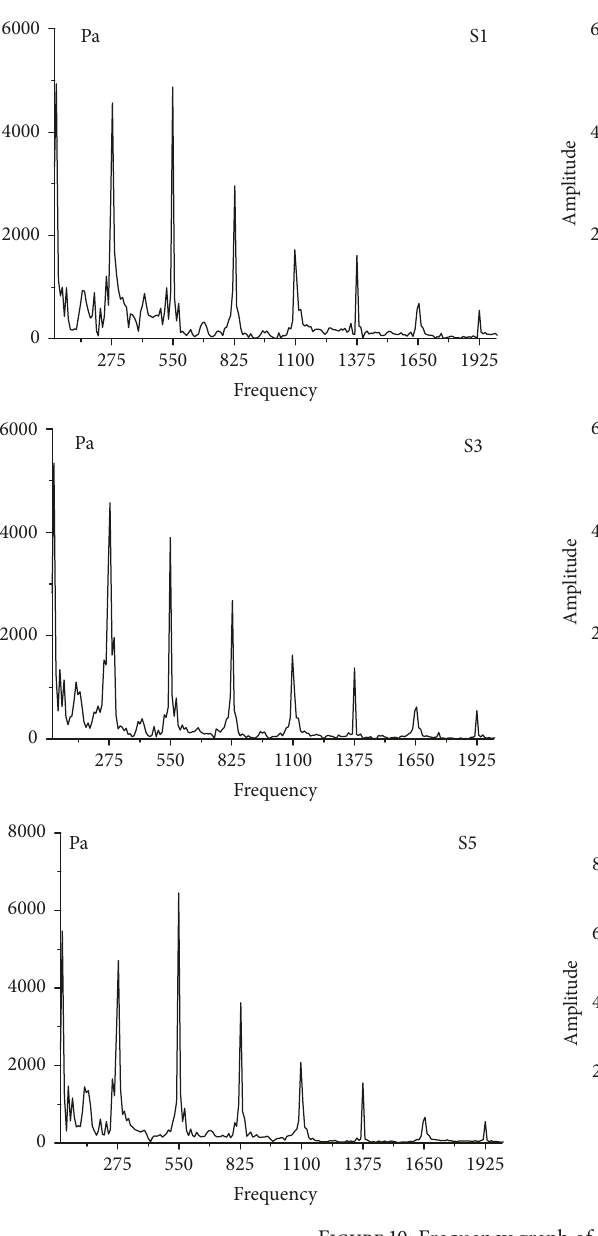
Figure 10: Frequency graph of monitors S1 ∼